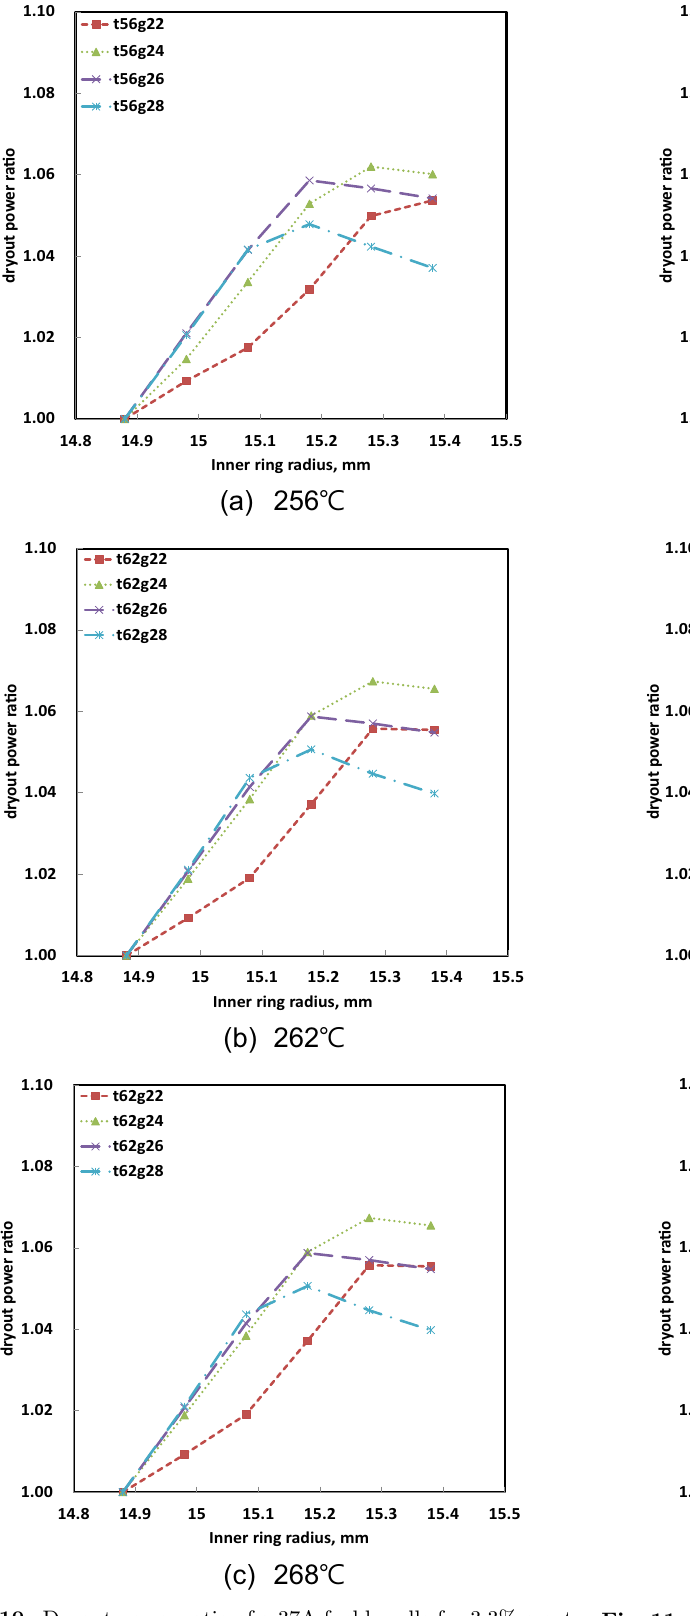
Fig. 11. Dryout power ratio of a 37A fuel bundle for 5.1% crept pressure